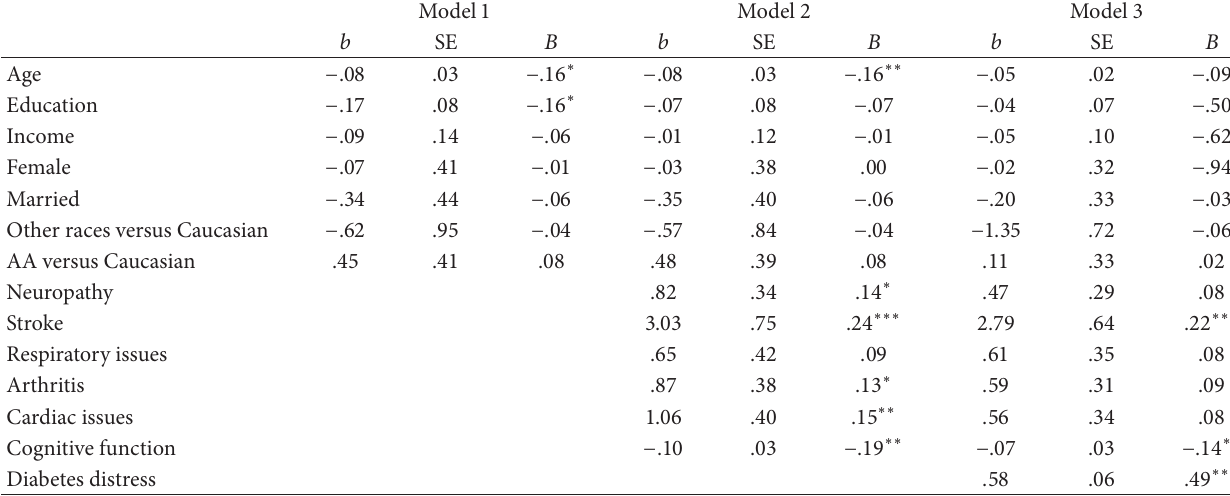
Table 3: Covariate-adjusted associations between depressive symptoms and demographics, health, and diabetes